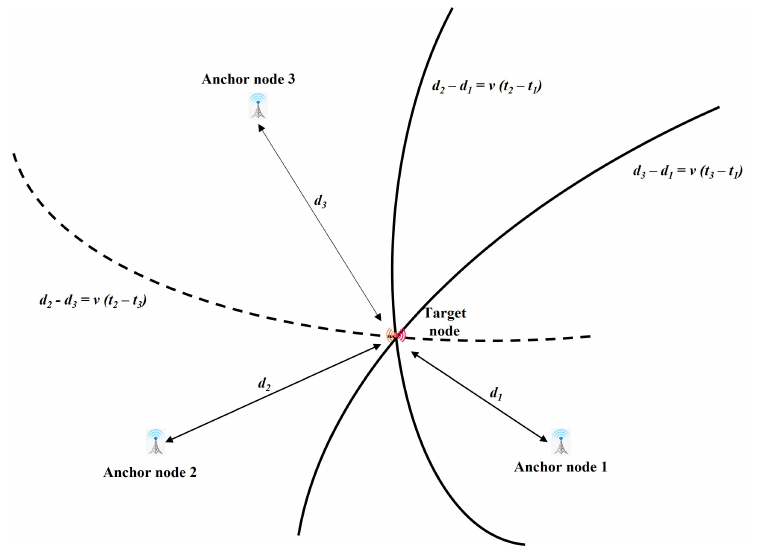
Figure 5. Hyperbolic localization technique, reproduced with permission from Zafari, A Survey of Indoor Localization Systems and Technologies; published by IEEE,